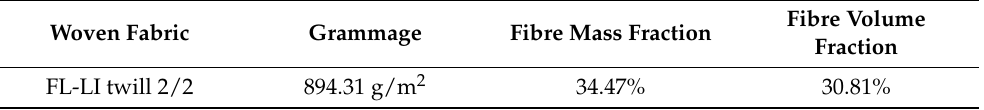
Table 7. Textile properties of the woven